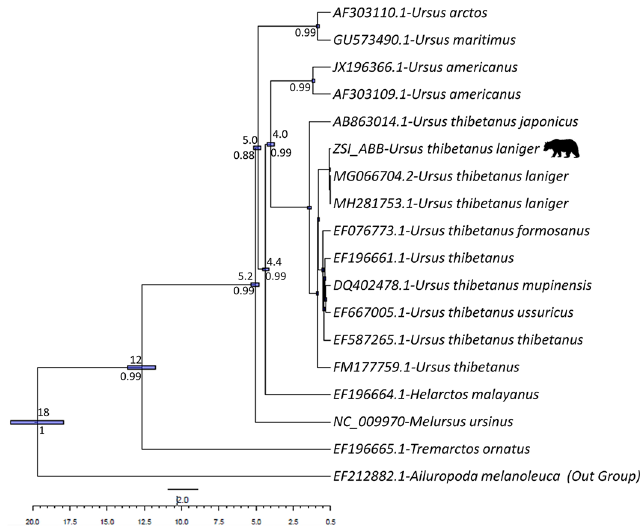
Figure 6. Phylogenetic relationship among Asiatic black bear and related species inferred from their whole mitochondrial genome using Bayesian inference. Posterior probability values are shown on each node. Ailuropoda melanoleuca (EF212882) was used as out-group.